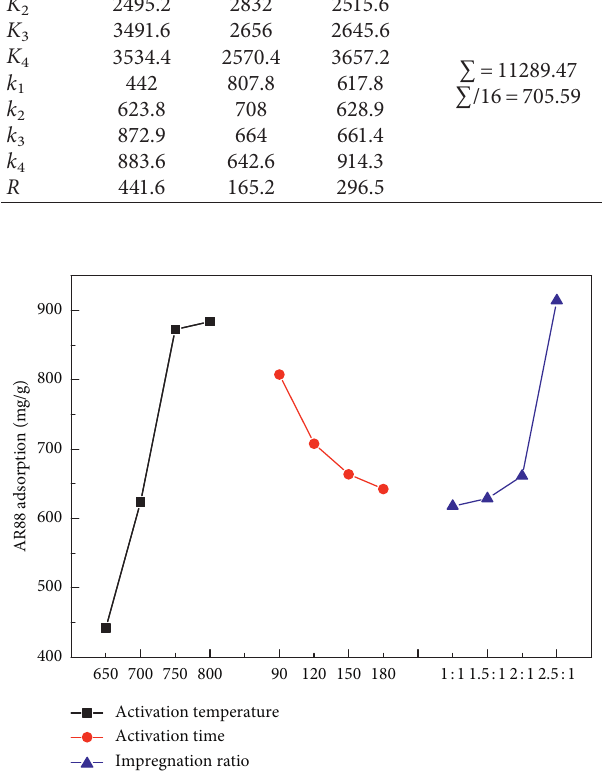
Figure 4: Effects of preparation conditions on AR88 adsorption of